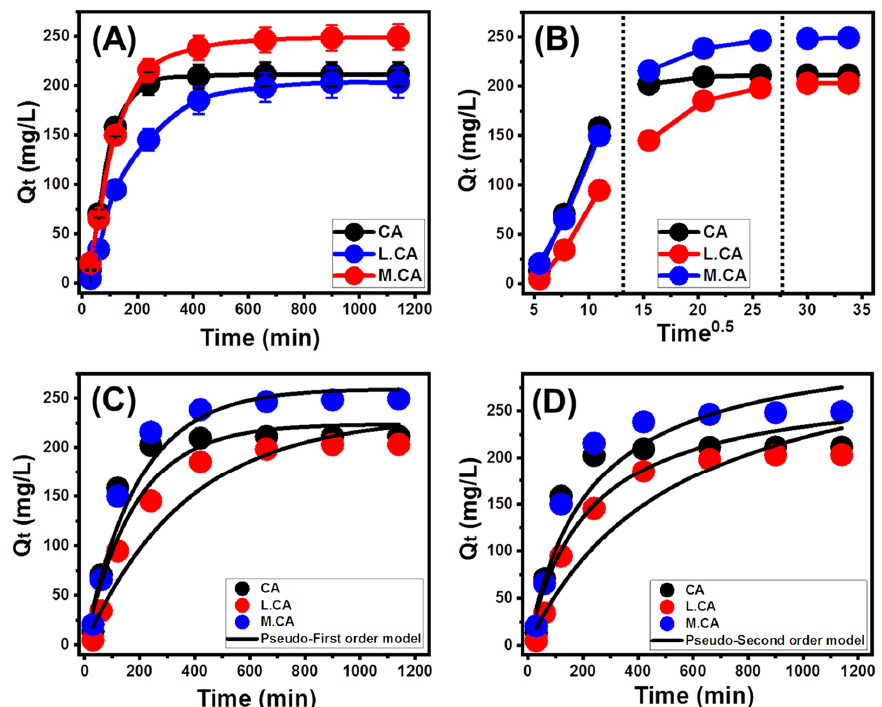
Figure 3. The impact of the contact time on the retention capacities of calcite phases for Zn (II) ions ( A ), the intra-particle diffusion curves of the Zn (II) retention results by the calcite phases ( B ), fitting of the Zn (II) retention results with the pseudo-first-order kinetic model ( C ), and fitting of the Zn (II) retention results with the pseudo-second-order kinetic model ( D ).